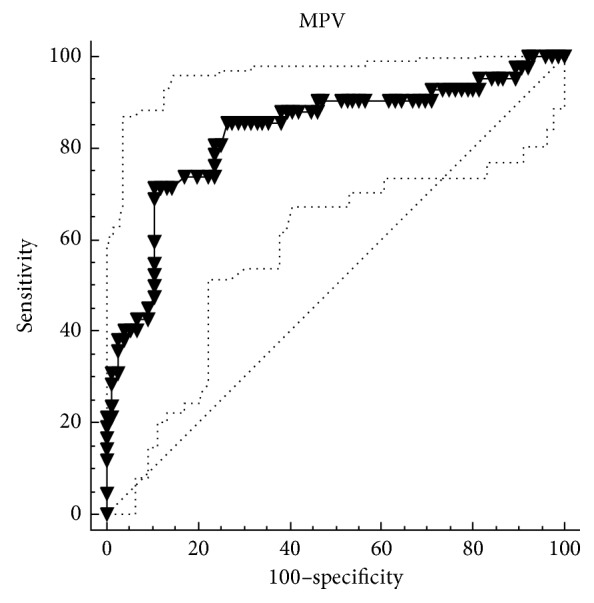
Optimized cutoff value was determined for the MPV using the ROC curve analysis.